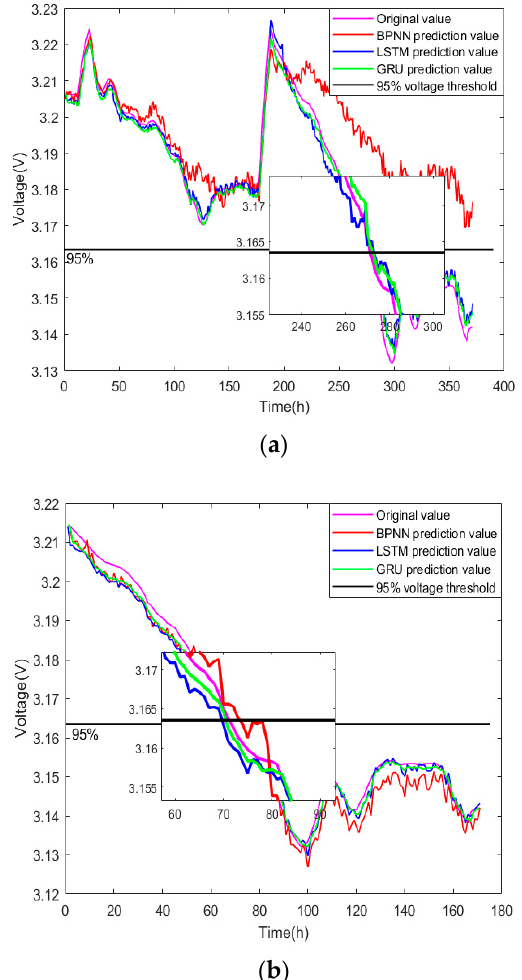
Figure 6. Comparisons of prediction effect between BPNN, LSTM and GRU: ( a ) starting point is 650 h and ( b ) starting point is 850 h.